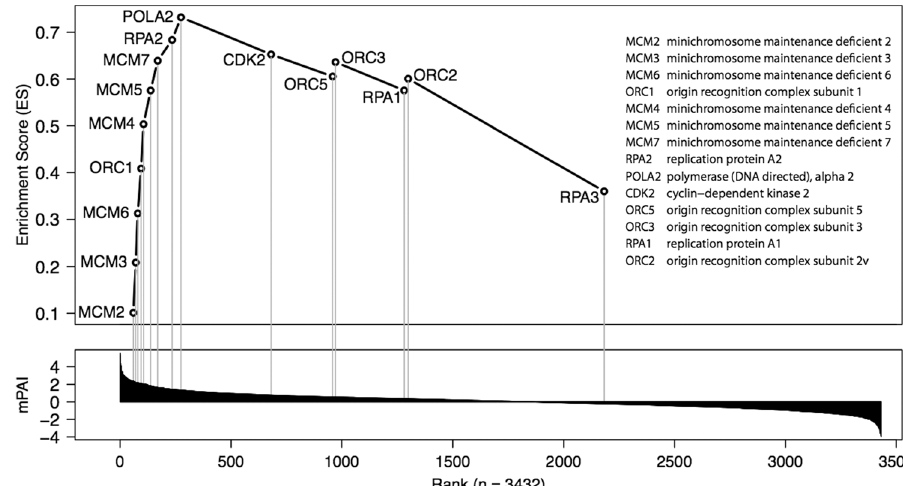
Fig. 2 Knockdown of mtp53 identi fi es enrichment of the pre-replicative complex pathway. GSEA analysis revealed a total of 27 and 17 Reactome pathways that are positively and negatively, respectively, associated with mtp53 abundance at a nominal P value < 1%. Enrichment of fi ve DNA replication-related gene sets and pathways including the pre-replicative complex consisting of 15 genes, shown here with their enrichment scores ( upper panel ) and mutant p53 association index (mPAI) ranks ( lower panel ). Full GSEA results are available at http://diverge. hunter.cuny.edu/~weigang/silac-chromatin-gsea/ (chromatin) and http://diverge.hunter.cuny.edu/Polotskaia_etal_2014/supp-table-s1/